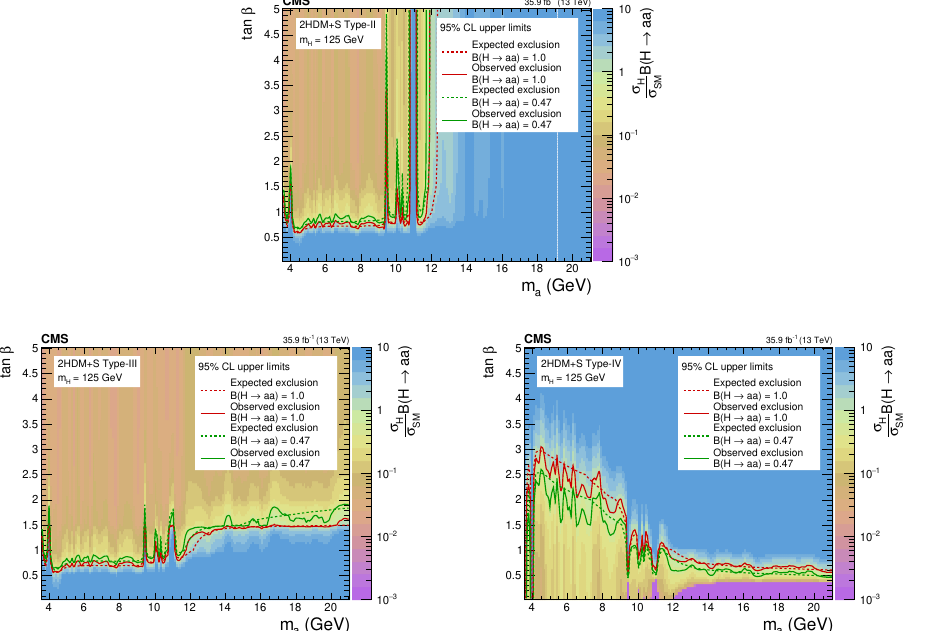
Figure 9 . Model-speci(cid:12)c 95% CL upper limits on (cid:27) of the 2HDM+S as a function of tan (cid:12) and m B (H ! aa) are shown for reference. The assumed model branching fractions for pseudoscalar